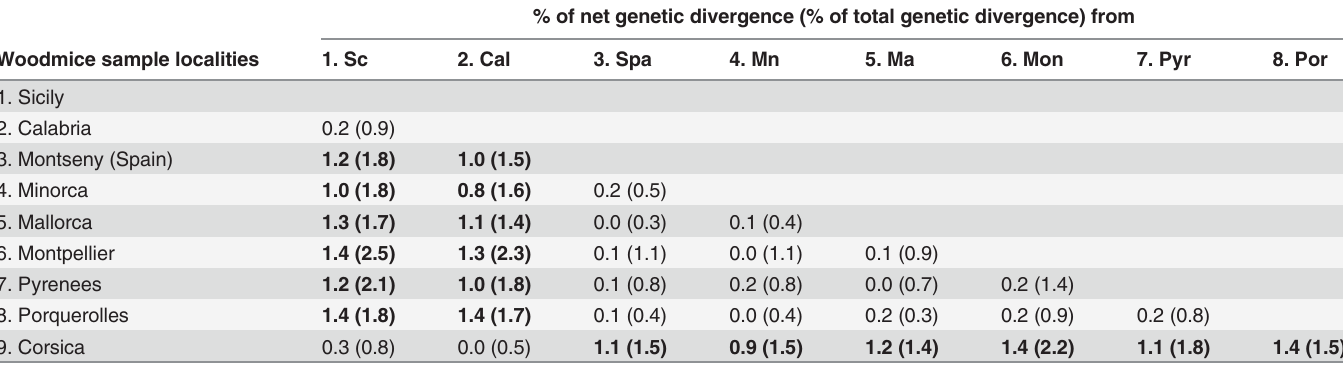
Table 3. Net and total genetic divergence existing among the Pneumocystis concatenated mtLSU and mtSSU sequences isolated from woodmice captured in various geographic localities. % of net genetic divergence (% of total genetic divergence)